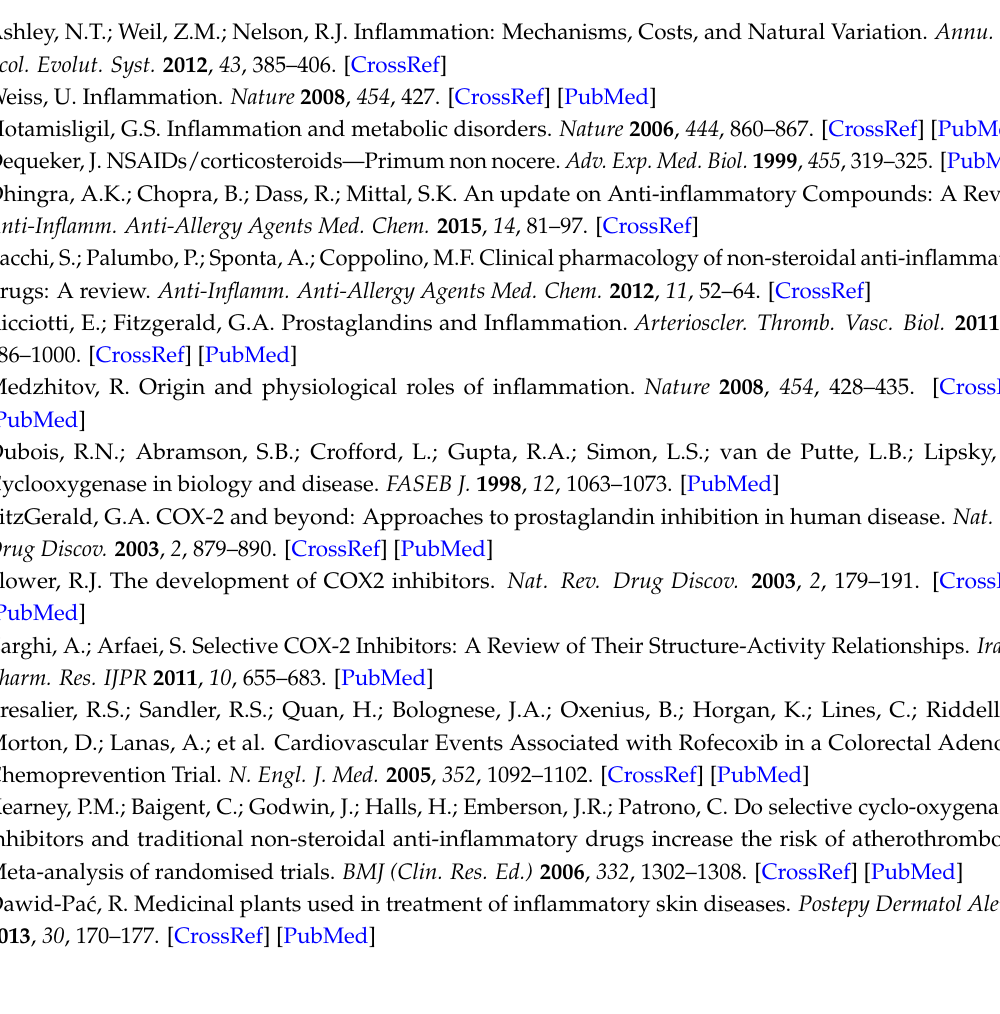
Figure S1: Chromatogram (TLC profile) of P. lanceolata extract after chlorophyl removal using n -hexane